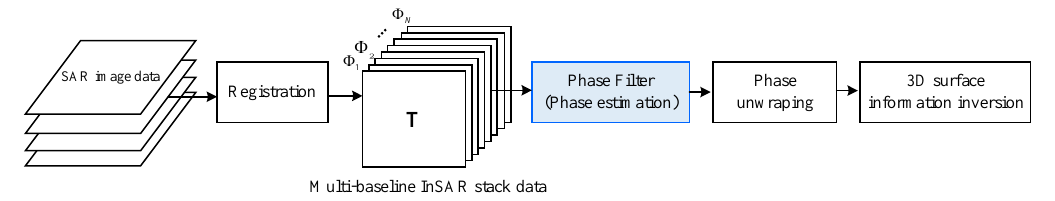
Figure 1. Flow chart of multi-pass SAR interferometry (InSAR) stack data processing.